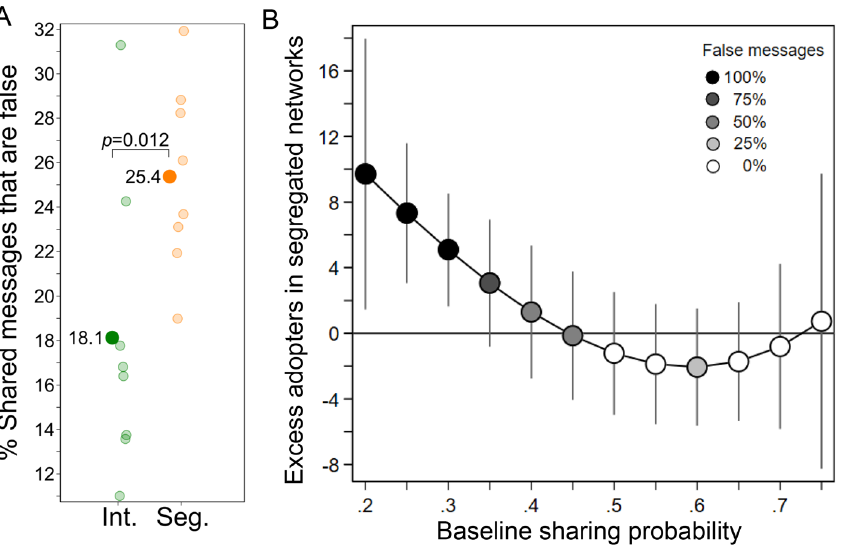
Figure 4. Misinformation proliferates in segregated networks. ( A ) Percentage of sharing decisions involving a false message in both network conditions. Each shaded circle represents one network. Consistent with our argument, we find that network segregation systematically increases the fraction of misinformation in the population (one-sided randomization test: ATE = 7.2%, p = 0.012, N = 16). ( B ) Difference in number of adopters between segregated and integrated networks by the messages’ baseline sharing probability (vertical lines denote corresponding 95% confidence intervals). The color shade indicates the fraction of false messages at different levels of sharing